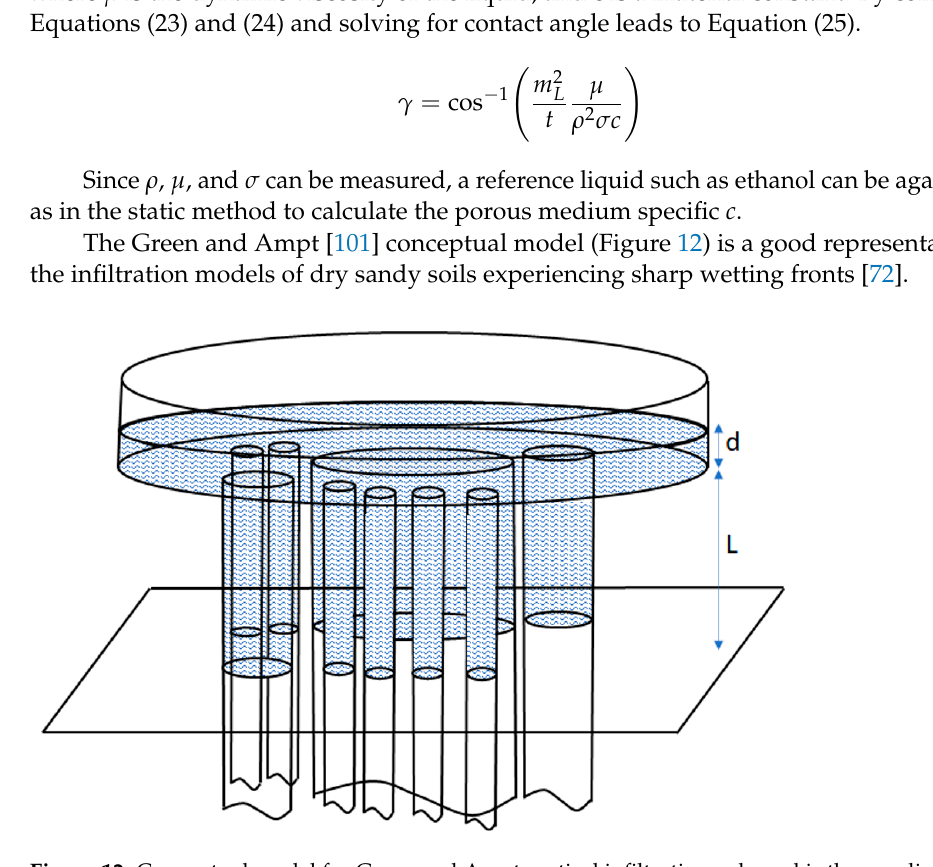
Figure 12. Conceptual model for Green and Ampt vertical infiltration, where d is the ponding depth, water is advanced to a depth L with the assumption of considering the porous medium with a set of parallel capillary tubes of different diameters, modified from [72].